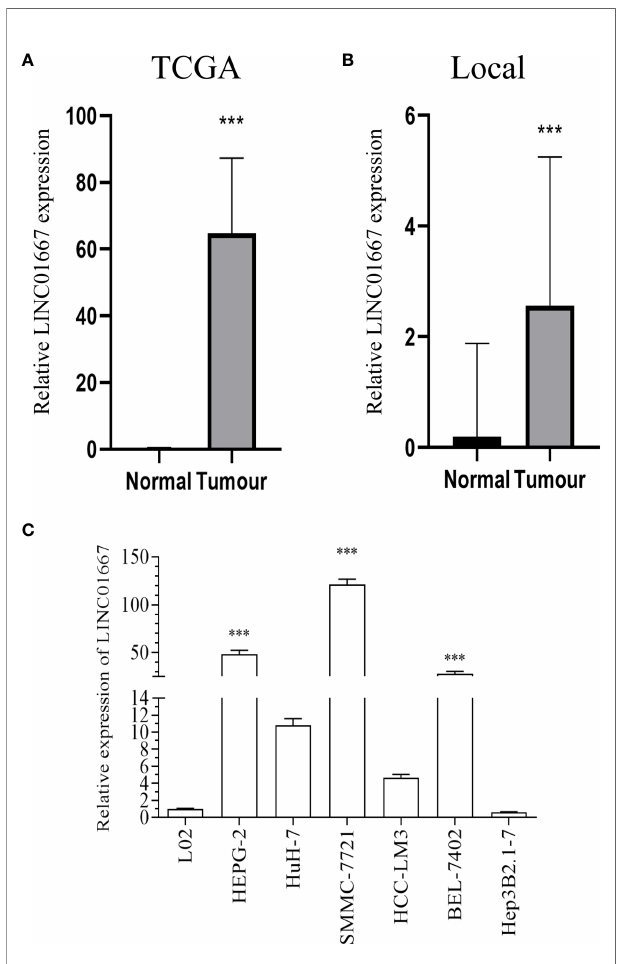
FIGURE 1 | LINC01667 was upregulated in HCC. (A) Relative LINC01667 expression in HCC tissues from patients versus normal samples from TCGA database (normal = 50, tumor = 374). (B) Relative LINC01667 expression in HCC tissues from patients versus normal samples from the local cohort (normal = 20, tumor = 20). *** P < 0.05. (C) In comparison with L02 cells, LINC01667 was upregulated in HCC cells (HepG2, Huh7, SMMC-7721, HCC-LM3, BEL-7402, Hep3B2.1-7). *** P <